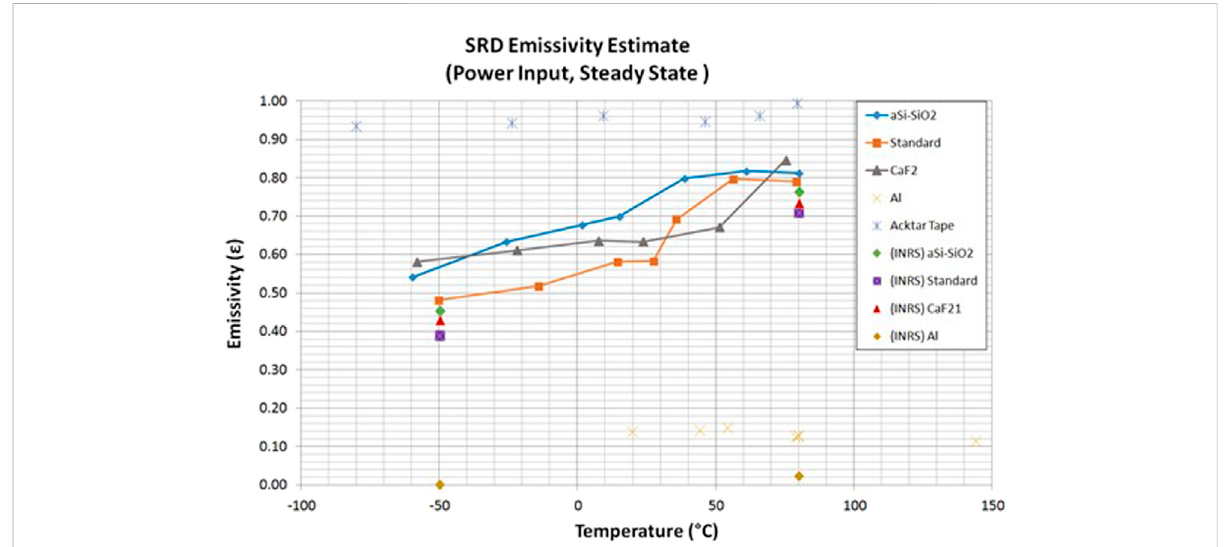
FIGURE 9 Emissivities of the fi ve samples obtained at the plateaus (steady-state power equilibrium).